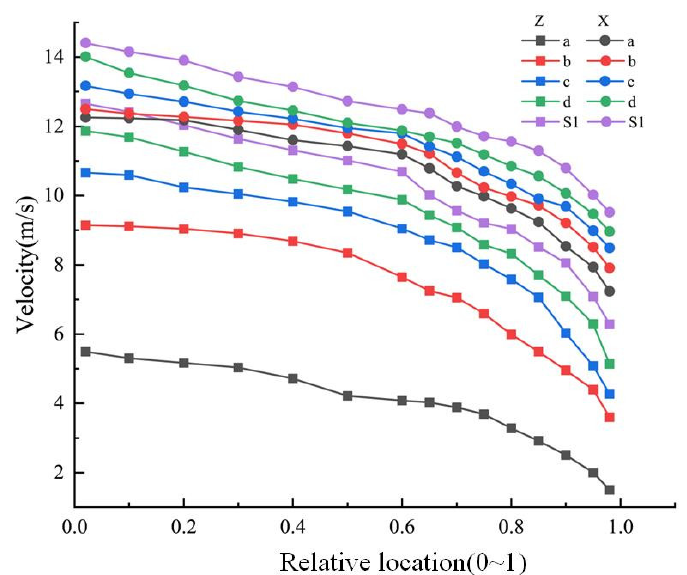
Figure 6. Velocity distribution of the flow path from the tail end of the deflector to the S1 section.